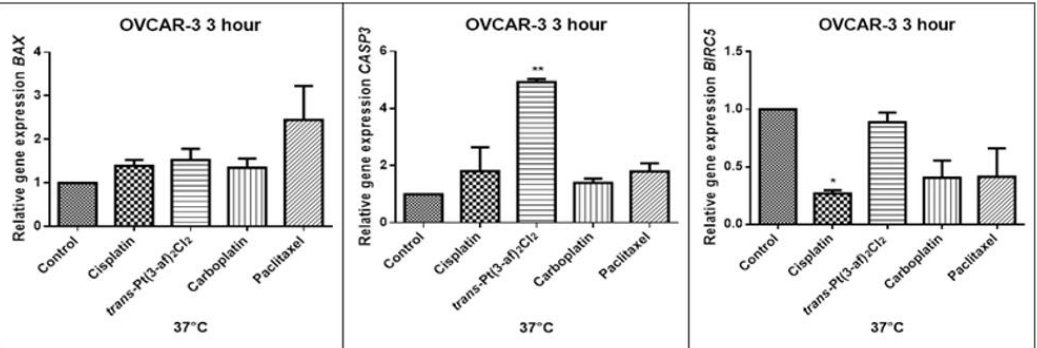
Figure 11. Level of gene expression of BAX, CASP-3, BIRC5 in ovarian cancer cells Caov-3. The gene expression level was presented as a relative value compared to a control equal to 1. The mean values marked by ** ( p < 0.01), *** ( p < 0.001) significantly differ statistically from the control.